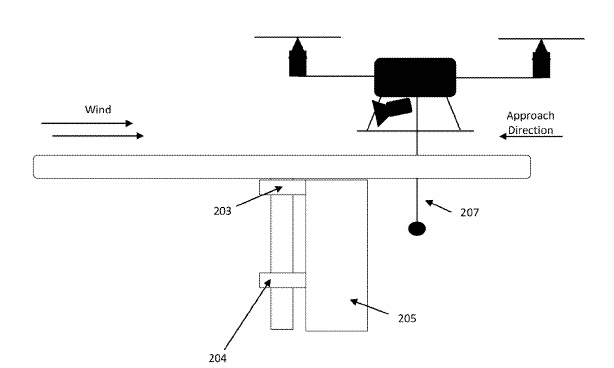
Figure 43. Unmanned aerial vehicle reload/refueling station [99]. 203, free rotation clutch 205; cable grab mechanism; 207,